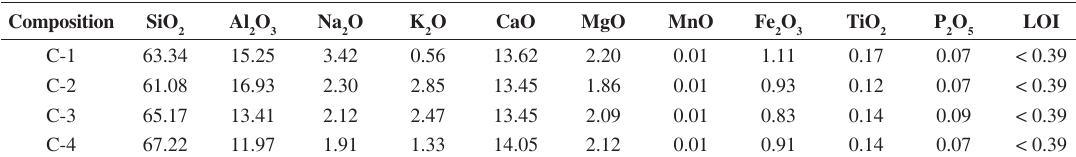
Table 3. Chemical composition (wt.%) of the investigated samples. Composition